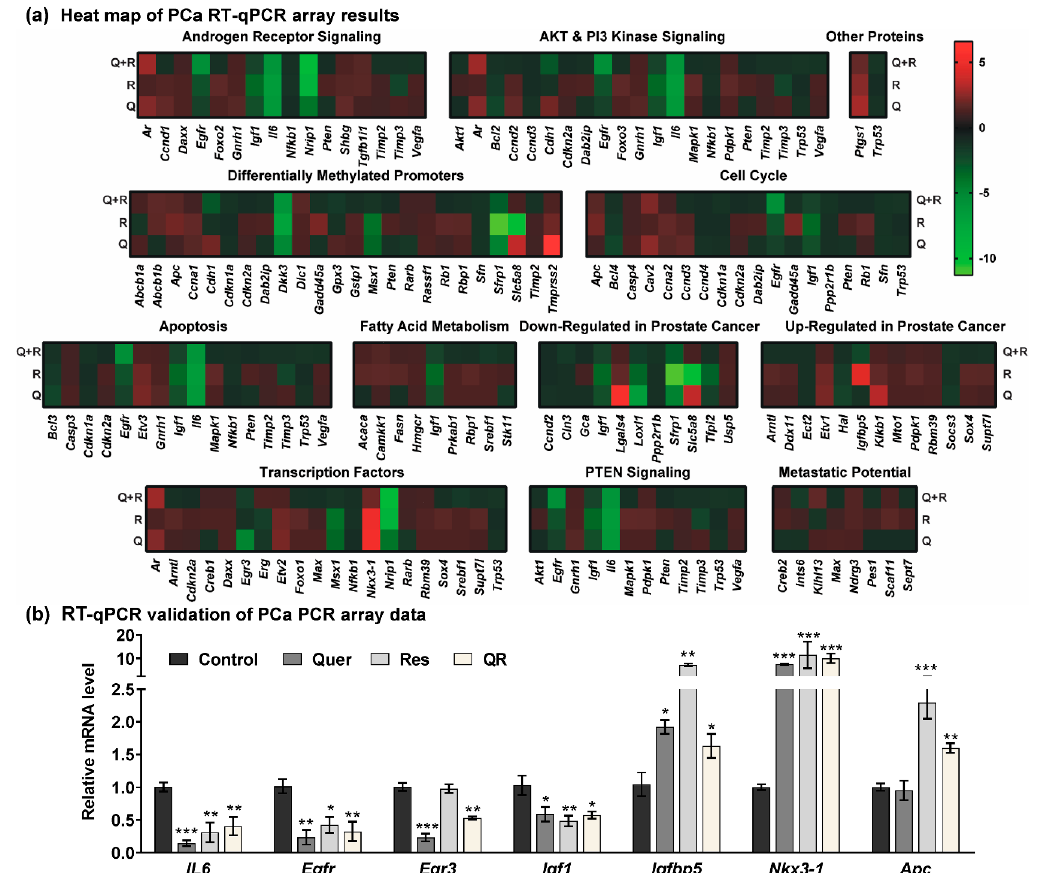
Figure 4. Quercetin and/or resveratrol modulate the expression of key PCa-related genes. The Figure4. Quercetinand / orresveratrolmodulatetheexpressionofkeyPCa-relatedgenes. Theexpression expression profiles of 84 genes involved in 12 different PCa-related phenomena were assessed using profiles of 84 genes involved in 12 di ff erent PCa-related phenomena were assessed using a Qiagen PCa a Qiagen PCa RT² Profiler PCR array. ( a ) Heat maps of the gene expression in quercetin (Q), RT 2 Profiler PCR array. ( a ) Heat maps of the gene expression in quercetin (Q), resveratrol (R), and resveratrol (R), and quercetin–resveratrol (QR) treated tumors are represented as the fold change quercetin–resveratrol (QR) treated tumors are represented as the fold change compared to the control compared to the control tumors. The assay was performed using two biological pools (as described tumors. The assay was performed using two biological pools (as described in materials and methods) in materials and methods) in triplicate within each group. Increased levels are indicated by red and in triplicate within each group. Increased levels are indicated by red and decreased levels are green. decreased levels are green. ( b ) Validation of key PCa genes identified from the PCa PCR array was ( b ) Validation of key PCa genes identified from the PCa PCR array was performed by RT-qPCR analysis. performed by RT-qPCR analysis. Data are presented as the mean ± SEM of two biological pools of Data are presented as the mean ± SEM of two biological pools of three animals per group ( n = 6) in three animals per group ( n = 6) in technical triplicate. A one-way ANOVA with Tukey’s multiple technical triplicate. A one-way ANOVA with Tukey’s multiple comparison test was performed using comparison test was performed using Graphpad Prism 5 software (* p <0.05, ** p < 0.01, *** p < 0.001). Graphpad Prism 5 software (* p < 0.05, ** p < 0.01, *** p < Based on the analysis of the Qiagen RT 2 Profiler PCa PCR array, we observed the modulation of several key genes known to affect the development and progression of prostate tumors. For validation of PCR array data, we selected a cut-off criteria of ≥ two-fold change in any one treatment group with statistically significant change ( p < 0.05), and ≥ 1.5-fold change in any other group. Of 84 genes tested, 22 were identified with these parameters for further analysis (Table 1). The expression of these genes was validated using RT-qPCR analysis, and genes with significant expression after validation are shown in Figure 4b. Validation data for inconclusive or non-significant data are shown in Figure S2.